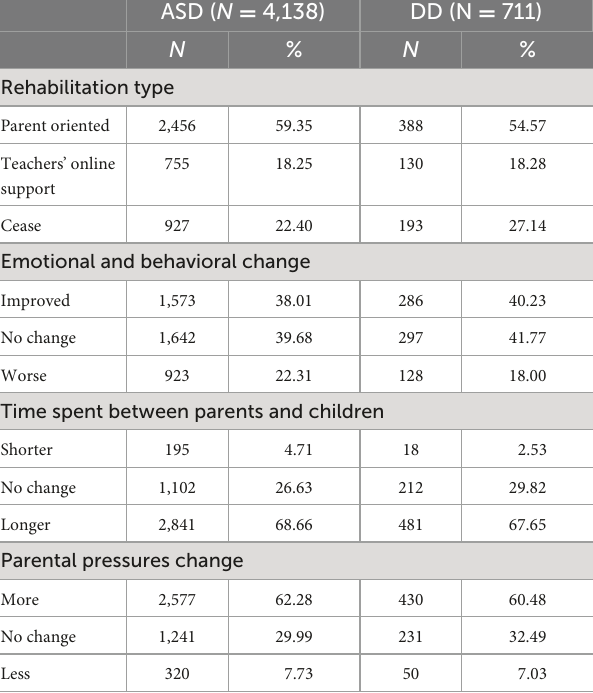
TABLE 3 Logistic regression analysis for variables predicting the negative emotional and behavioral change* of children.